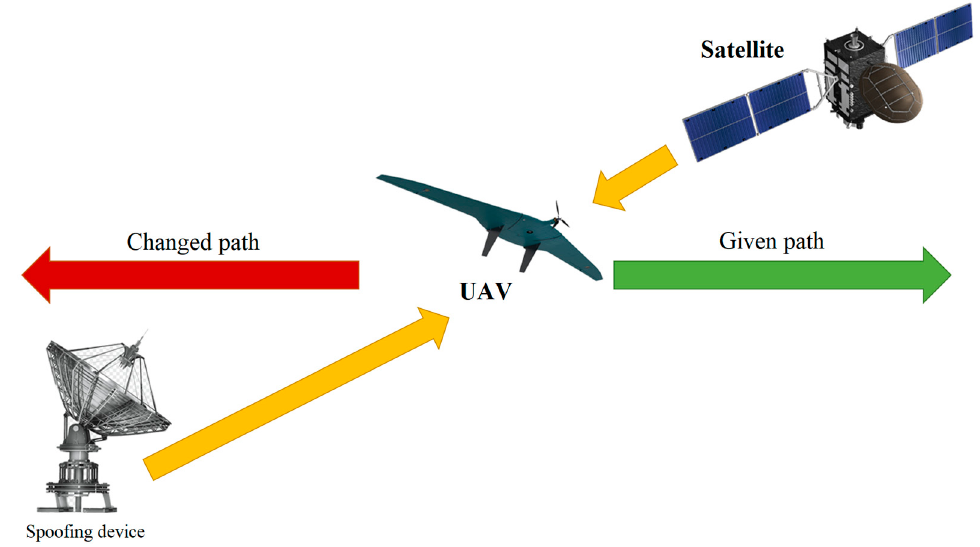
Figure 5. Scheme of GPS spoofing attacks on UAV.